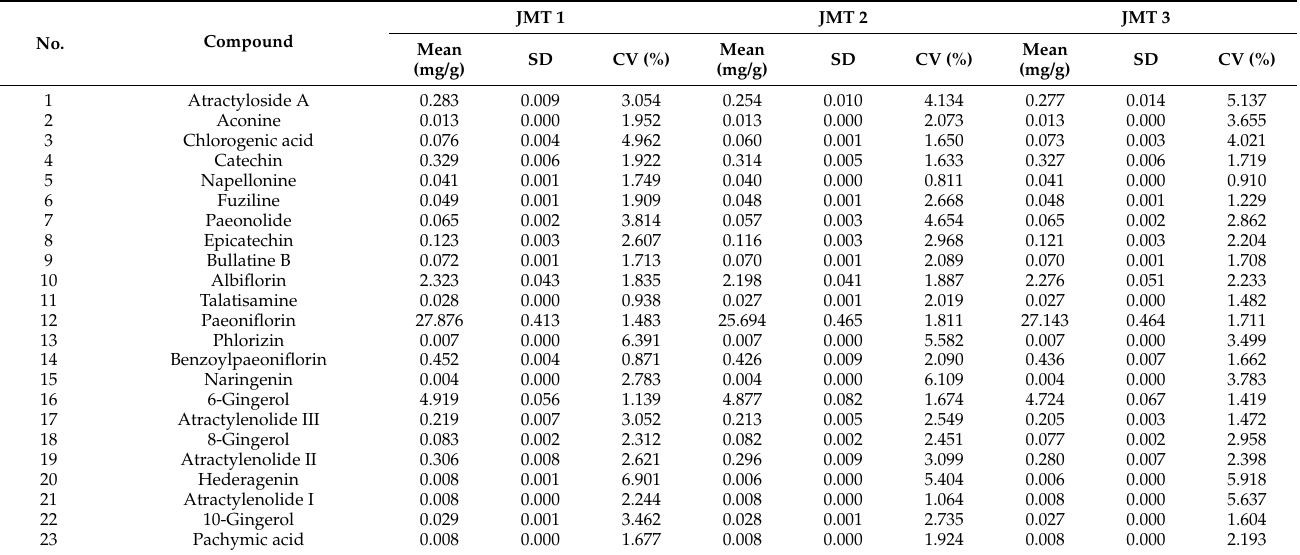
Table 5. Content of the 23 compounds in different batches